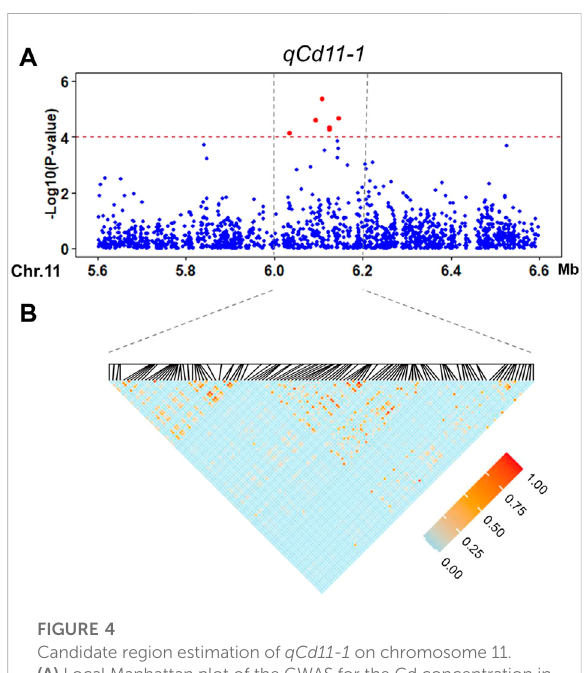
FIGURE 4 Candidate region estimation of qCd11-1 on chromosome 11. (A) Local Manhattan plot of the GWAS for the Cd concentration in the shoot. (B) LD heatmap around the most signi fi cant